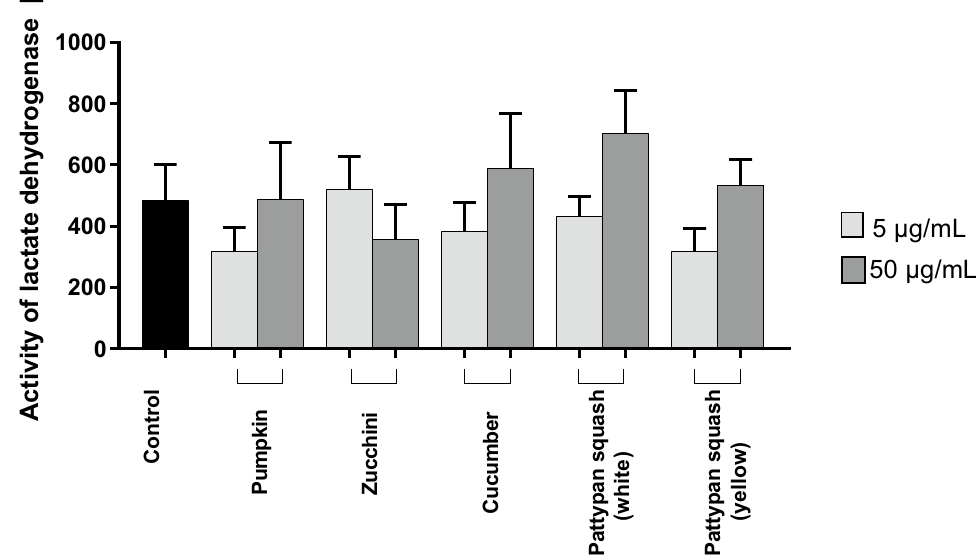
Figure 1. Effects of the five cucurbit vegetable preparations (concentrations 5 and 50 µg/mL, incubation time—30 min) on damage to human blood platelets. Results are given as mean ± SD (n = 4); the control sample (platelets without plant preparation). There wasn’t any statistically significant between effect of 5 and 50 µg/mL (p > 0.05). The baseline spectral reading (absorbance) for plant preparations range between 0.009 and